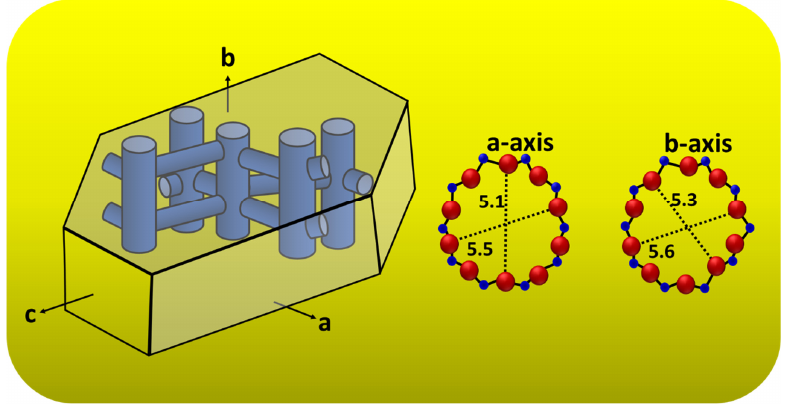
Figure 7. Schematic diagram of an MFI crystal and overview of the channel system of a-axis and b-axis. Table 1. Comparison of morphology parameters of as-synthesized silicalite-1 in this work and the samples reported in the literature.